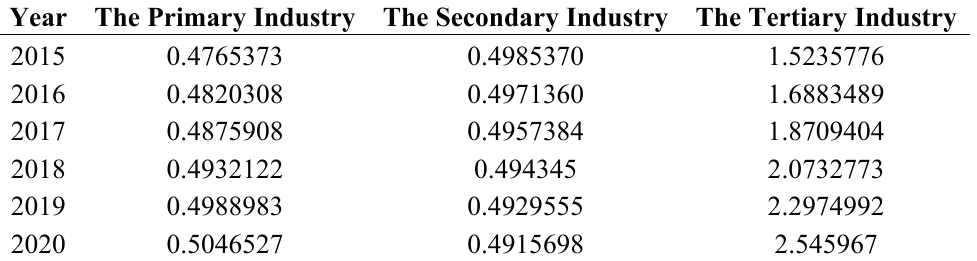
Table 7. Predicted values of the capital investments needed per 100 million yuan (100 million yuan).